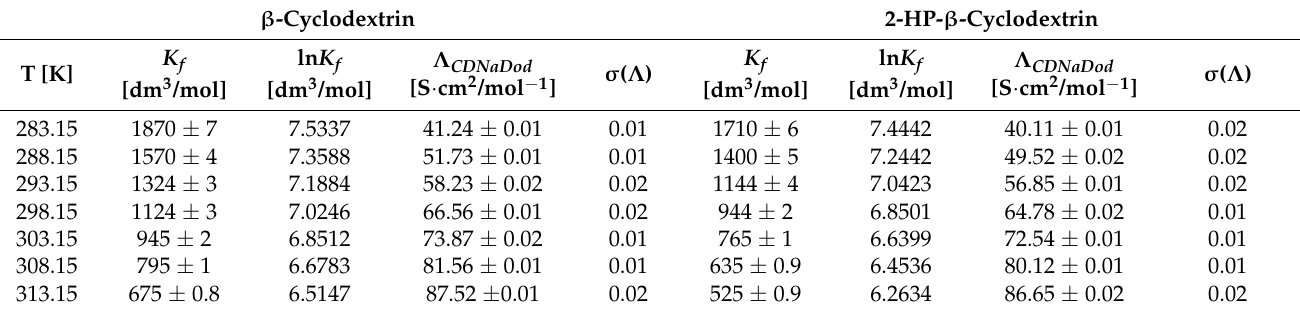
Table 2. The value of constant formation K f [dm 3 /mol], theoretical conductivity Λ CDNaDod [S · cm 2 /mol − 1 ] for β -cyclodextrin and 2-HP- β -cyclodextrin with the salt of trans – p -coumaric acid.